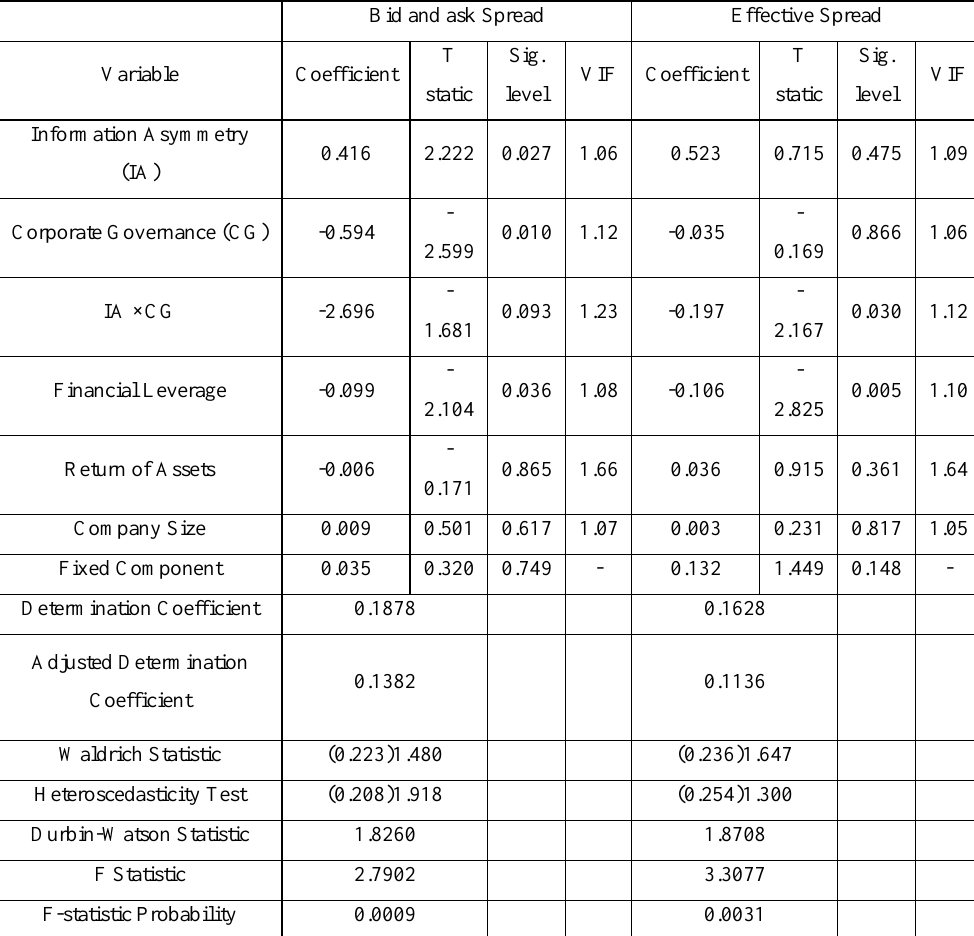
Table 7. Estimation results of research